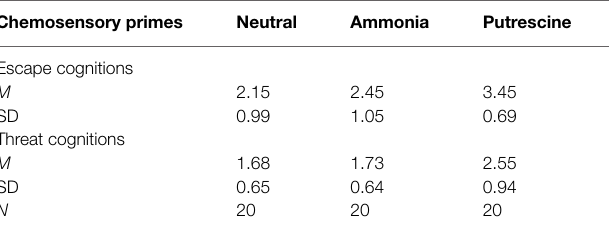
TABLE 5 | The ratings of escape-related and threat-related cognitions for the chemosensory primes (Experiment 3). Chemosensory primes